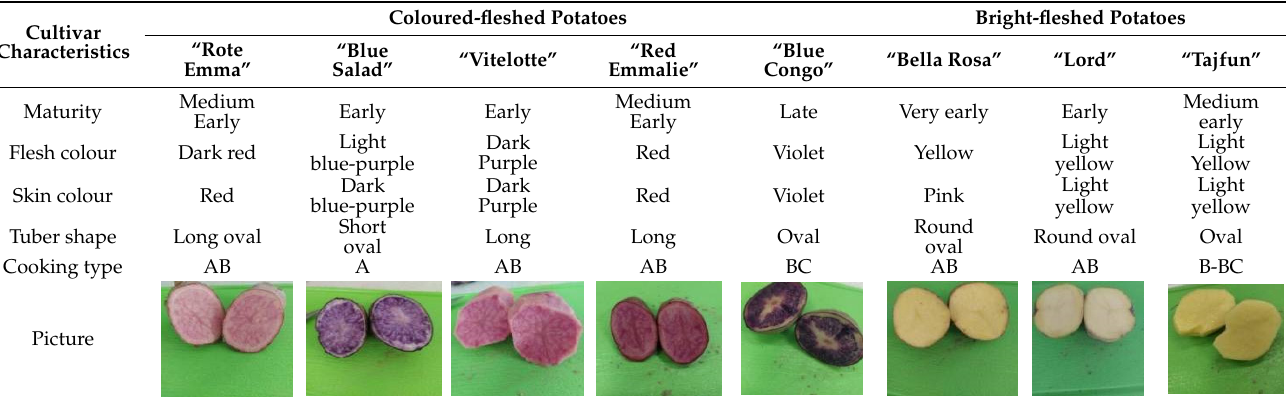
Cooking type B: Potatoes that are slightly floury, disintegrating, and with rather fine-textured flesh (European Associa- tion for Potato Research cooking type scale); Cooking type C: Potatoes that are dry, with floury flesh, coarse, and a rather marked disintegration (European Association for Potato Research cooking type scale) [4].